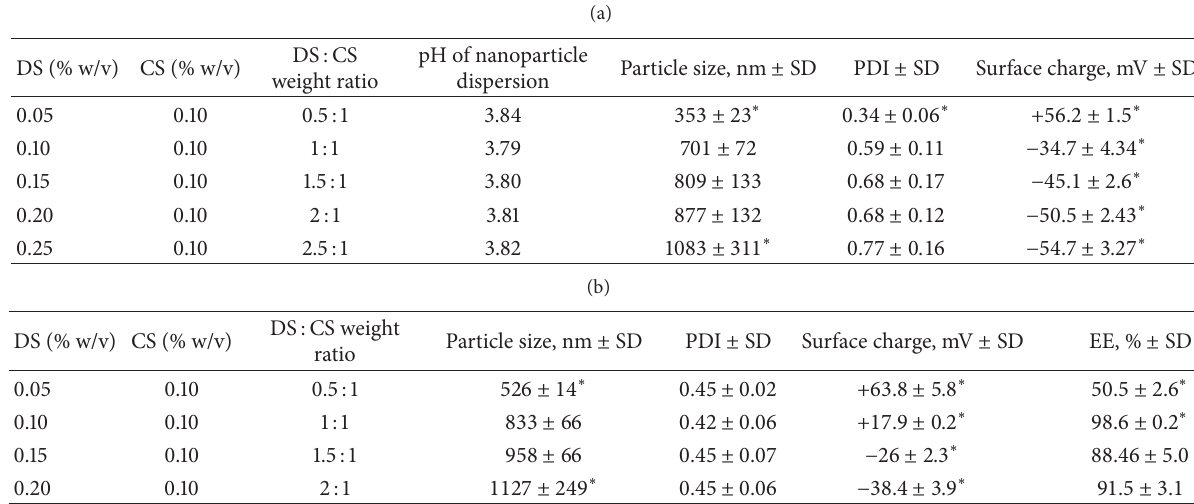
Table 1: Effects of DS :CS weight ratios on the physical characteristics of unloaded (top) and BSA loaded (below) CS NPs, 𝑛 = 3 . CS solution